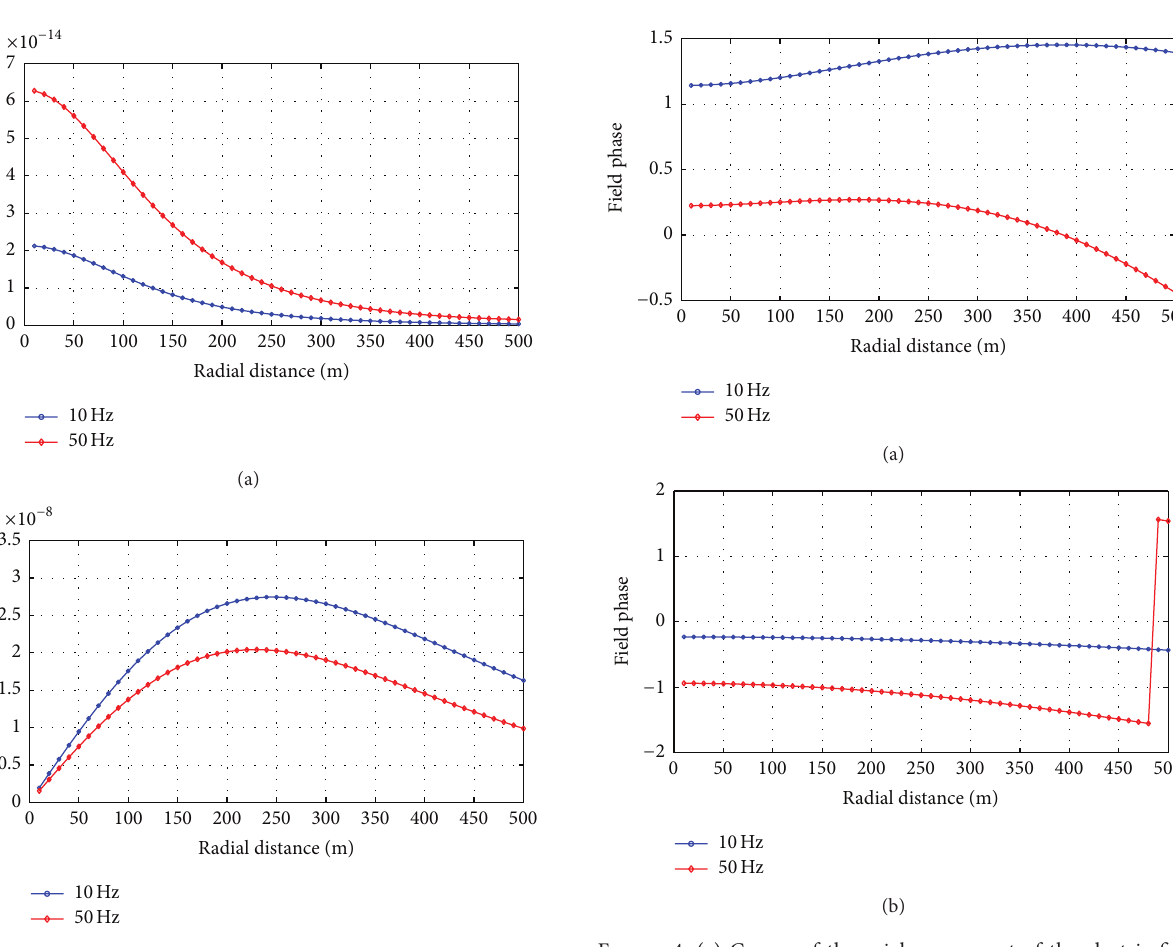
Figure 4: (a) Curves of the axial component of the electric field phase; (b) curves of the radial component of the electric field